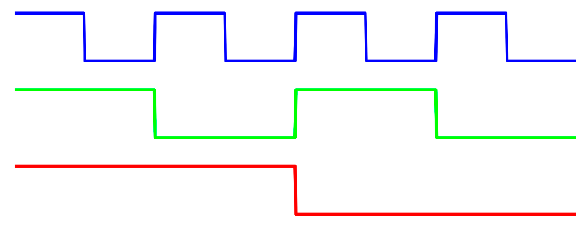
Figure 1. The binary gray-level ( b GL) method.